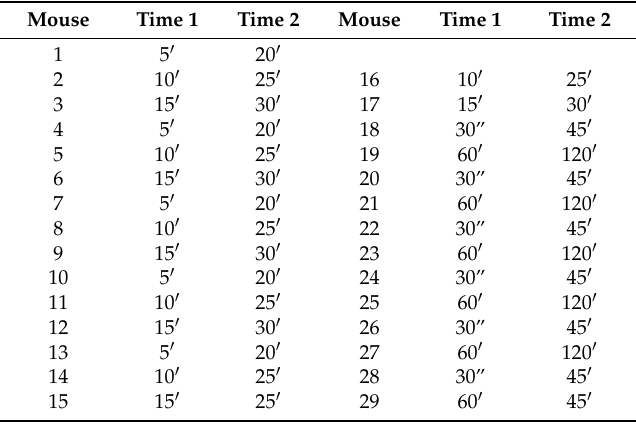
Table 2. Different times at which blood drawings were performed after the acute treatment are listed. In order to minimize animal sufferings, each mouse underwent only two